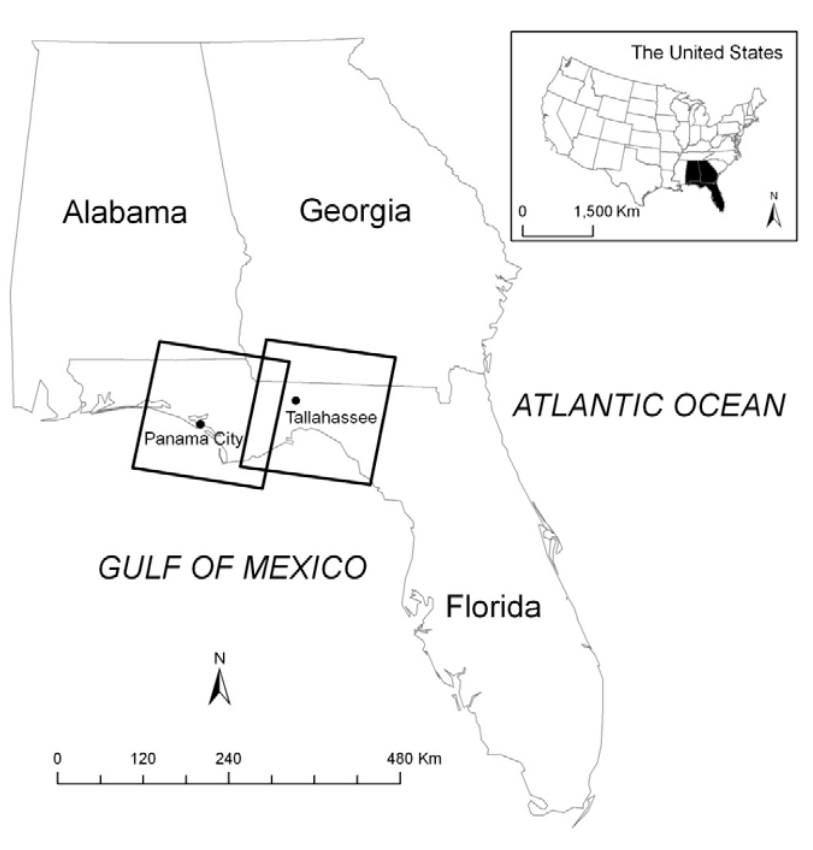
Figure 1. The location of the study area. The two boxes with thick black lines indicate the coverage of the two